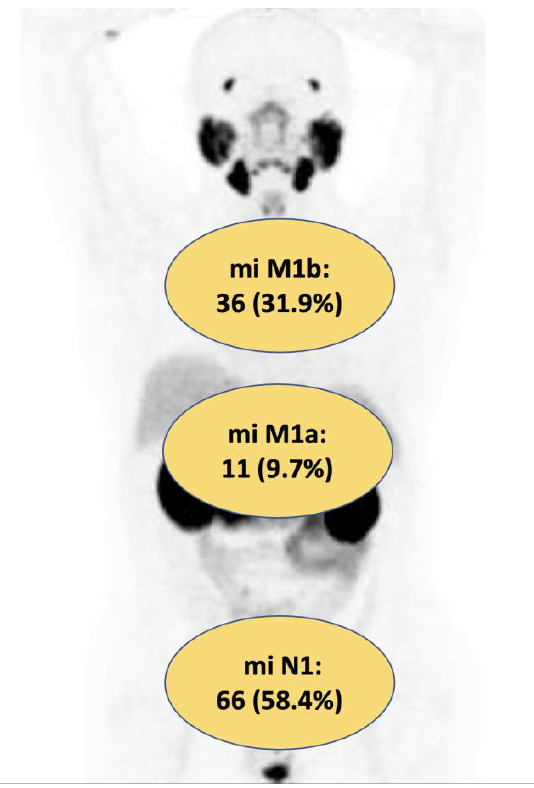
Figure 2. Localization of oligorecurrent disease detected by PSMA-PET according to miTNM. The median (IQR) follow-up from RP and PSMA-PET was 52 months (30 – 94), and after PSMA-PET it was 31 (19 – 42) months. According to the Kaplan-Meier curve, the 3- years PFS estimates were 41.8% and 13.8% in patients who underwent MDT and the conventional approach, respectively ( p = 0.3, Figure 3a). At 3-years follow up, the MFS estimates were significantly higher in patients undergoing MDT compared to men treated with the conventional approach (73.5% vs. 30.5%, p < 0.001; Figure 3b). In the overall population, the CRPC-FS estimates at 3 years were significantly higher in patients who underwent MDT compared to men treated with the conventional approach (94.7% vs. 79.5%, p < 0.001; Figure 3c).